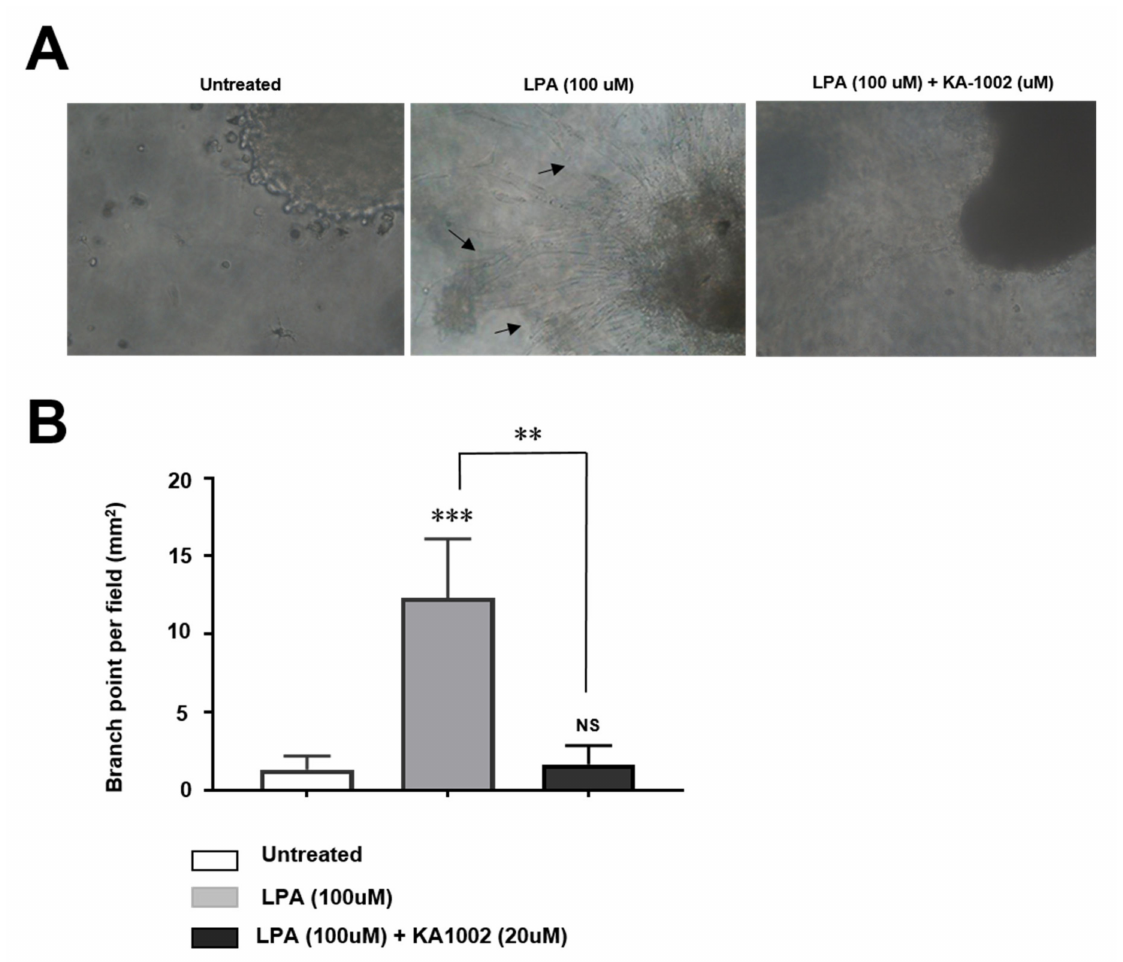
Figure 2. Inhibitory e ff ects of KA-1002 on LPA-induced angiogenesis of bovine blood vessel cell line, CAPE. ( A ) Representative images of the CAPE cells exposed to 100 µ M of LPA in the presence or absence of 20 µ M KA-1002 for 3 days were from three di ff erent independent experiments. ( B ) Quantification of tube network was calculated using Imaris software (Oxford Instruments). Pooled results are shown from 3 independent experiments. * p < 0.05, ** p < 0.01, or ** p < 0.001 indicate significant di ff erences in comparison to the LPA-treated group according to two-tailed unpaired Student’s t-testing. Error bars denote standard error